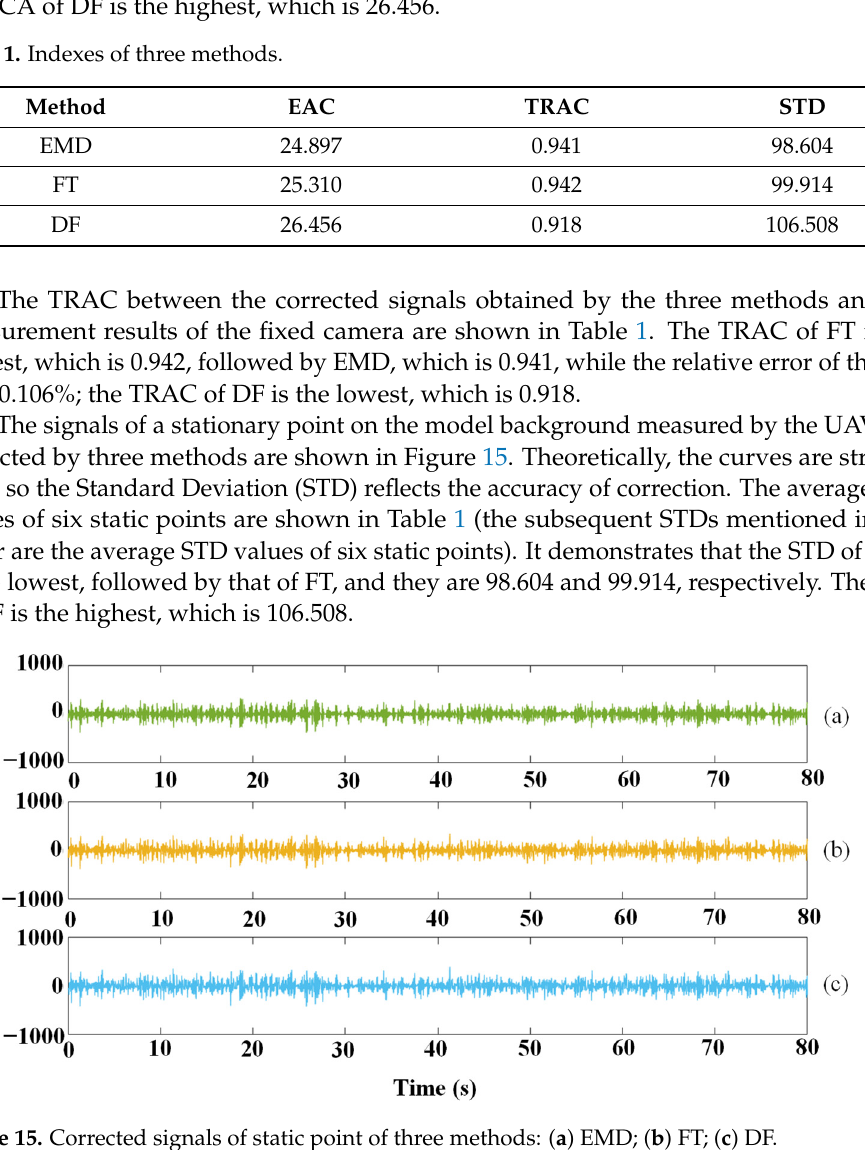
Figure 16. PSD curves of four cases: ( a ) fixed camera; ( b ) EMD; ( c ) FT; ( d ) DF. Figure 17 shows the mode shape obtained from the acceleration signals of three correction methods and the fixed camera measurement. The modal assurance criterion (MAC) [42] is used to evaluate the fitting degree between the mode shape curves. The mode shape obtained by the fixed camera is taken as the reference, the MAC values of EMD, FT, and DF are 0.994, 0.986, and 0.981, respectively. Based on the above analysis, EMD is the best in the three correction techniques of signal measured by UAVs on processing effect and modal parameter identification of bridge models.